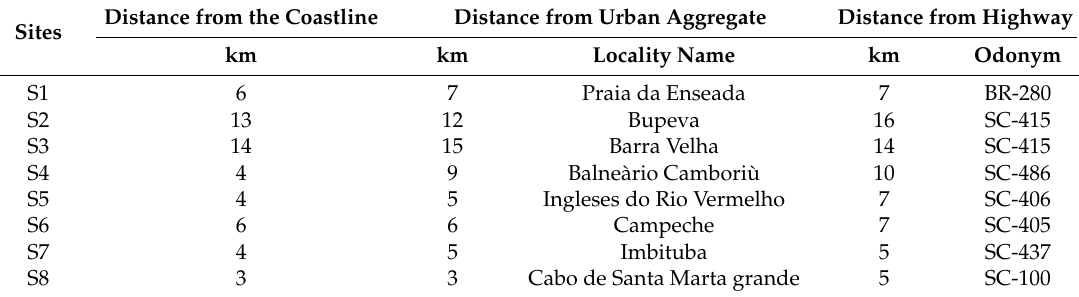
Table 7. Distance of each site from the coastline, urban aggregate, and nearest highway. Distance from the Coastline Distance from Urban Aggregate Distance from Highway Sites km